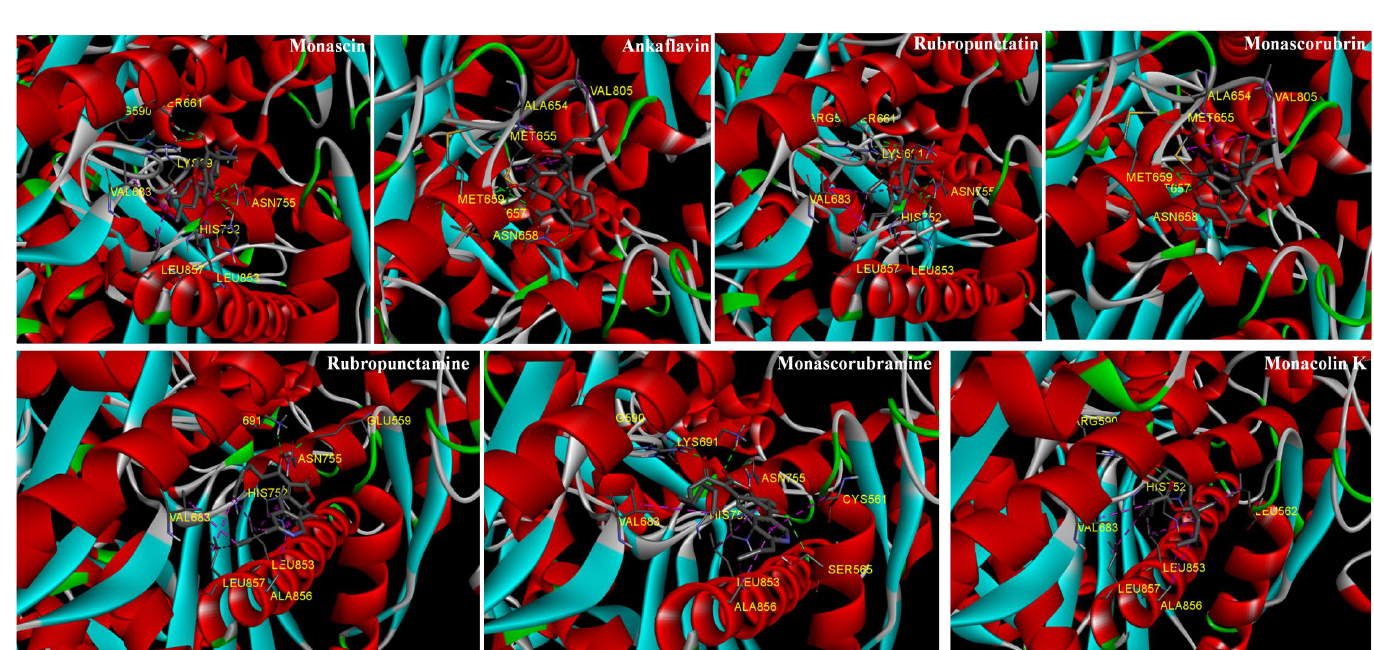
Figure 6. Predicted binding mode of Monascus pigments to HMGR (PDB: 1HW9). The best scored docking pose is shown. Green dashed lines are hydrogen bonds, and purple dashed lines are hydrophobic interactions.